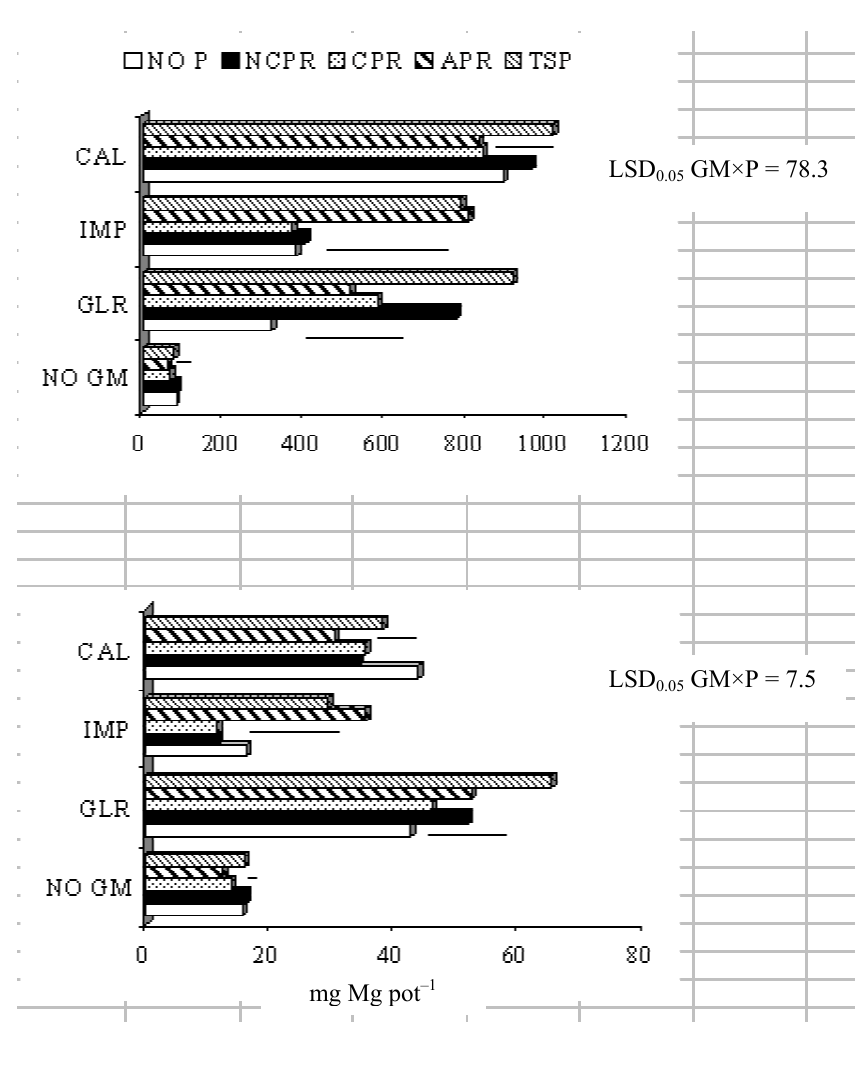
FIGURE 11. Uptake of K and Mg by Setaria sphacelata after 20 weeks growth in a tropical soil as affected by GMs and P fertilizers. Horizontal lines = LSD 0.05 .